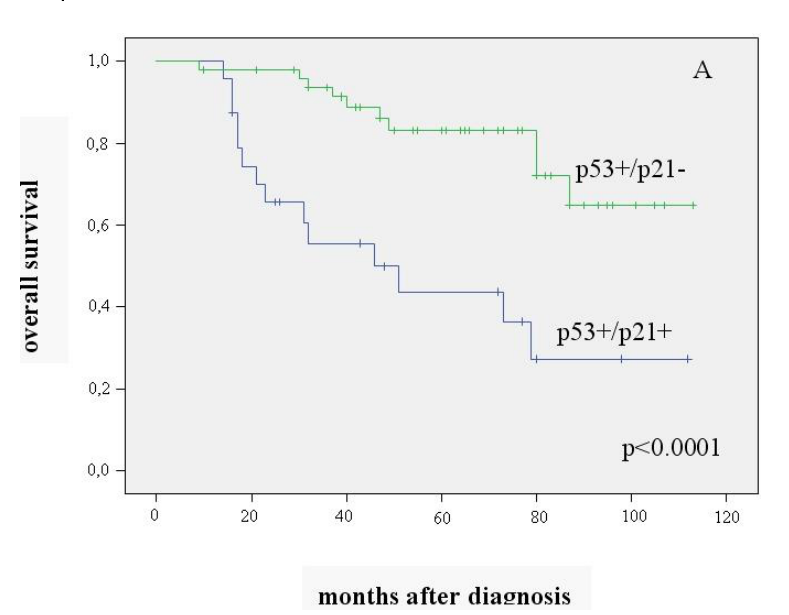
Figure 2. Overall survival ( A ) and recurrence-free survival ( B ) in relation to p53+/p21− and p53+/p21+ expression (n =